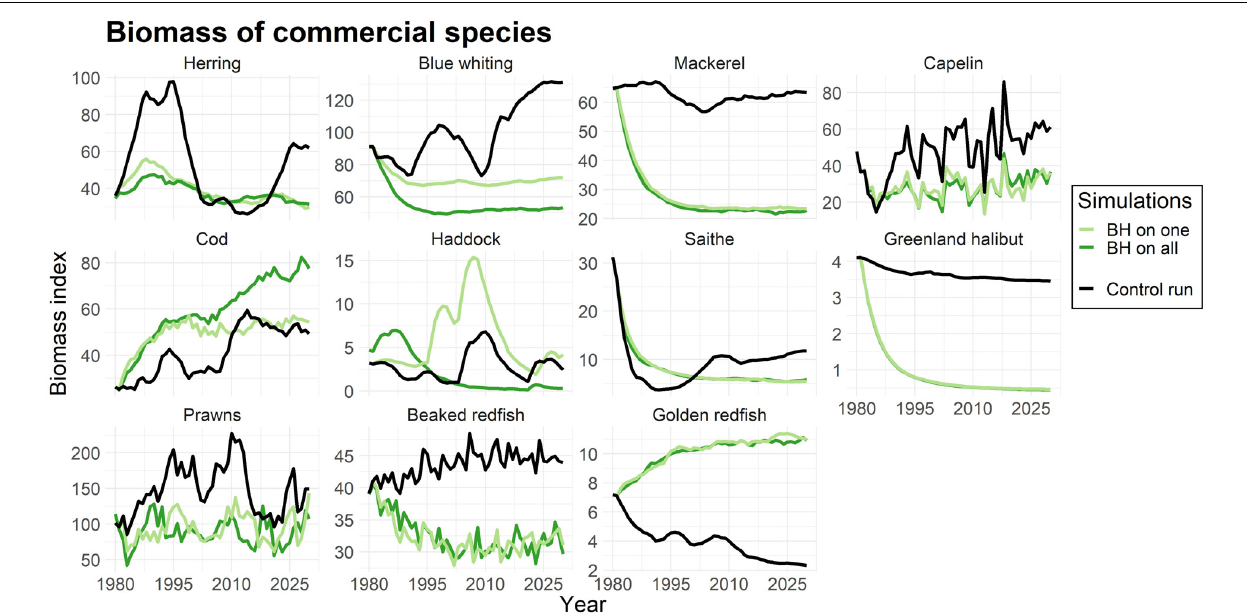
FIGURE 2 | Change in biomass compared to control run for commercial species. The light green line represents simulations were only that species were subjected to a BH regime, while the dark green line shows the biomass when all species in the study were subjected to BH. The black line displays the control run where a traditional fishing regime was applied. The biomass is given as an index.